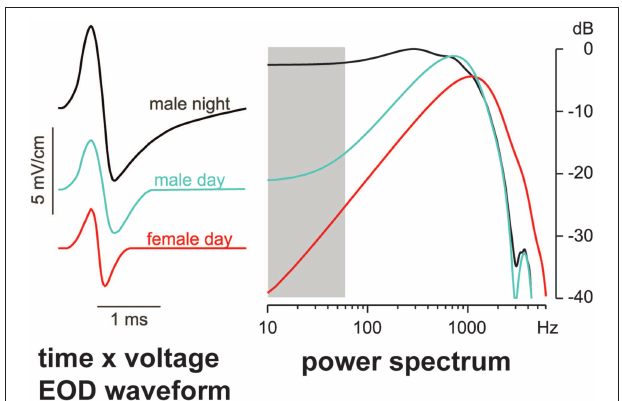
FIGURE 6 | Male Brachyhypopomus gauderio extend the second phase of the EOD, creating DC-asymmetry, which boosts energy in the frequency range of ampullary electroreceptors (gray bar). Accordingly, males have more low-frequency energy than females, and even more at night when they further enhance the signal. Adapted from Stoddard and Markham (2008) with permission of the